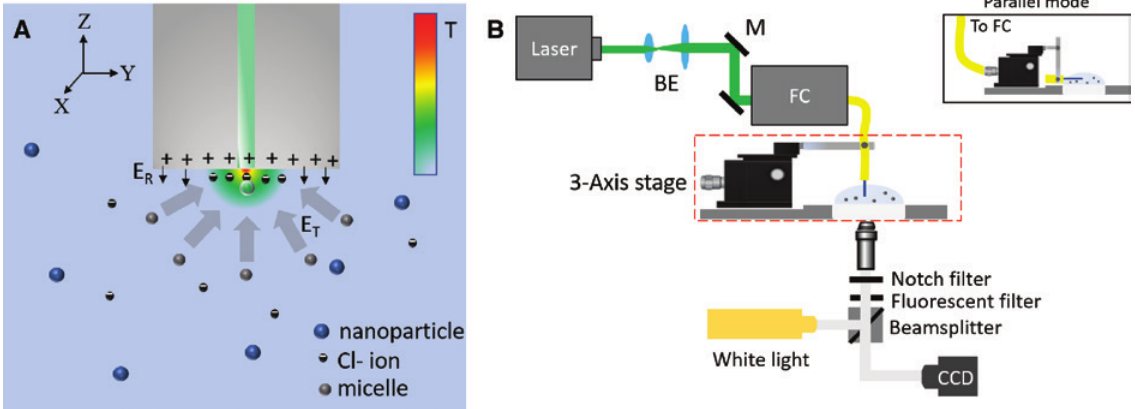
Figure 1: OTFT design, working principle and experimental set-up. (A) Schematic of the OTFT immersed in the trapping solution consisting of micellar ions, counterions, and the nanoparticles to be trapped. A temperature distribution is embedded in the schematic to show the temperature gradient created due to the thermoplasmonic fiber tip. (B) Schematic showing the experimental setup for trapping and manipulation of nanoparticles in 3D using OTFT. The red dashed box shows the arrangement of OTFT in normal mode. For parallel mode operation, the set up in red dashed box is replaced with the arrangement shown in the figure inset. BE, beam expander; M, mirror; FC, fiber coupler; CCD, charge coupled